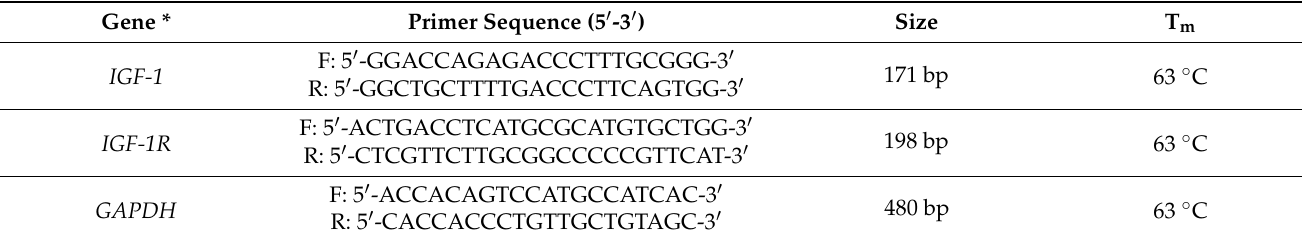
Table 1. Mouse primers and PCR conditions used in this